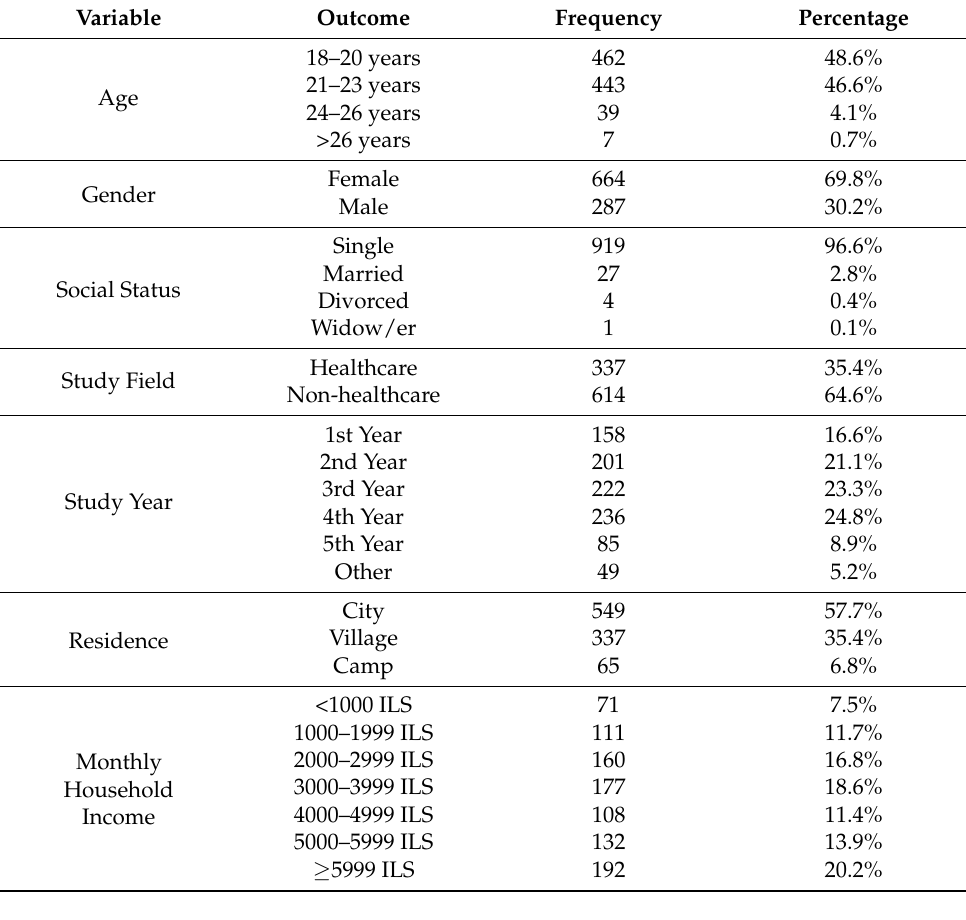
Table 2. Demographic characteristics of the participating students, May 2020 ( n = 951).